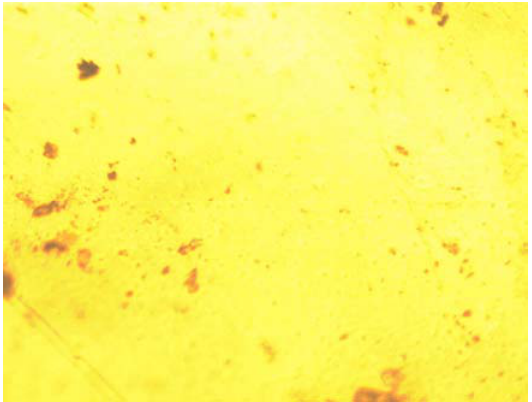
Figure 3. Image of the surface of polymer thin